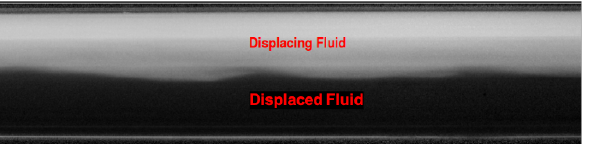
Figure 2. Example of an image showing both displacing and displaced